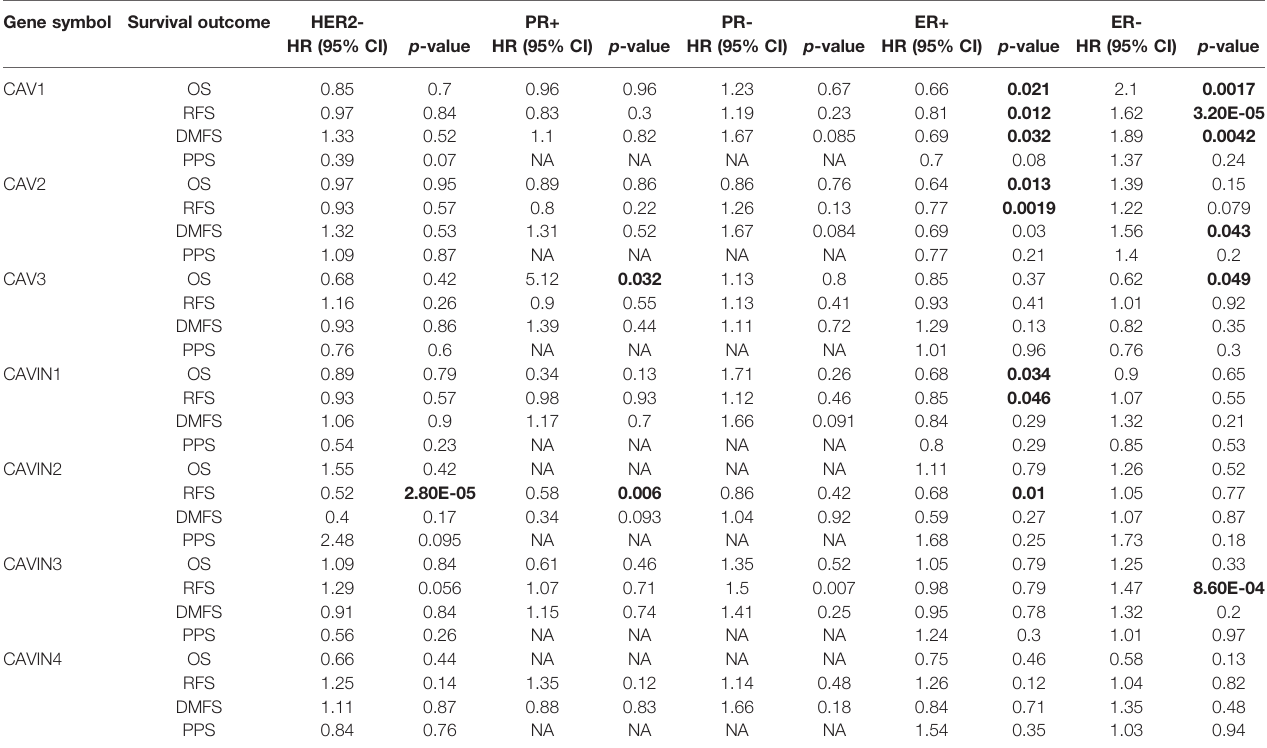
TABLE 4 | Correlation of CAVs/CAVINs transcription levels and survivals of patients with different HR/HER2 status of breast cancer. Gene symbol Survival outcome HER2-